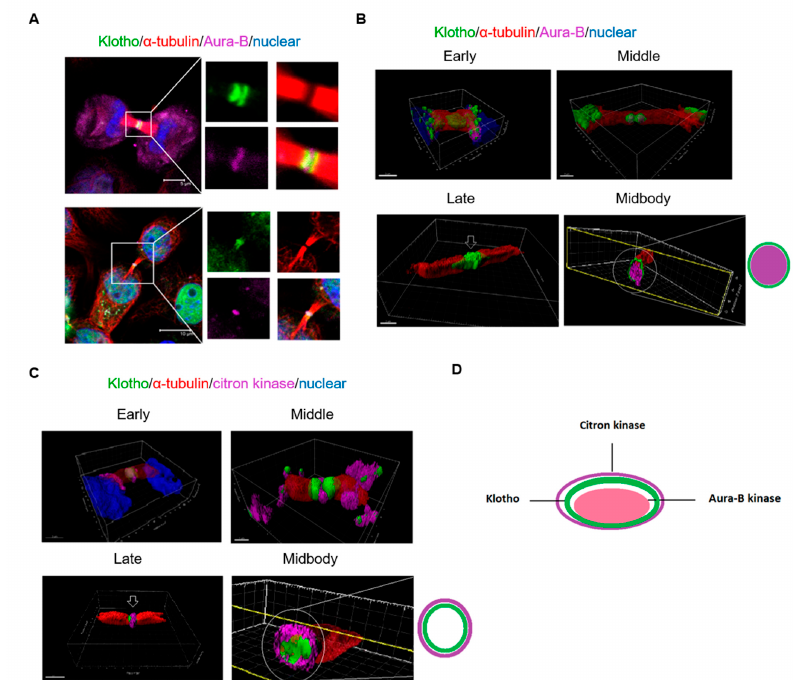
Figure 7. 3D reconstruction of the cytokinesis bridge. Intrinsic Klotho, Aurora kinase B, and citron kinase of cultured HeLa cells analyzed by immunofluorescence. ( A ) Results of immunofluorescence staining for Klotho and Aurora kinase B. ( B ) 3D structure of Klotho and Aurora kinase B in the cytokinesis bridge. ( C ) 3D structure of Klotho and citron kinase in the cytokinesis bridge. ( D ) Midbody architecture related with Klotho, Aurora kinase B, and citron kinase (microscopy: ×400).